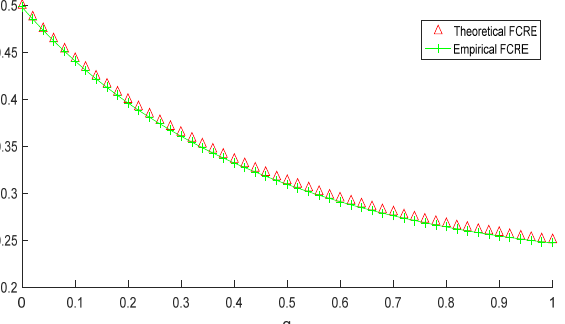
Figure 6. The fractional cumulative residual entropy and empirical fractional cumulative residual entropy of the uniform distribution on [0, 1] .